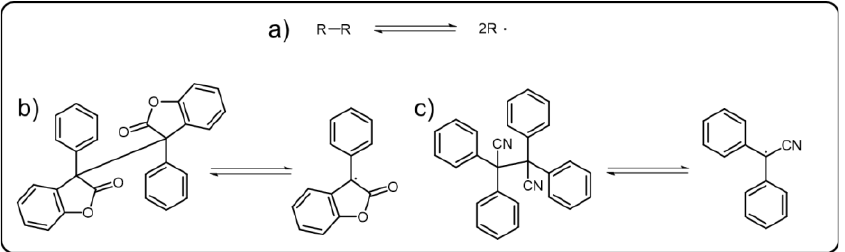
Scheme 7. ( a ) Schematic representation of reversible dynamic C-C bond. The typical central radicals derived from ( b ) DABBF and ( c ) TASN.